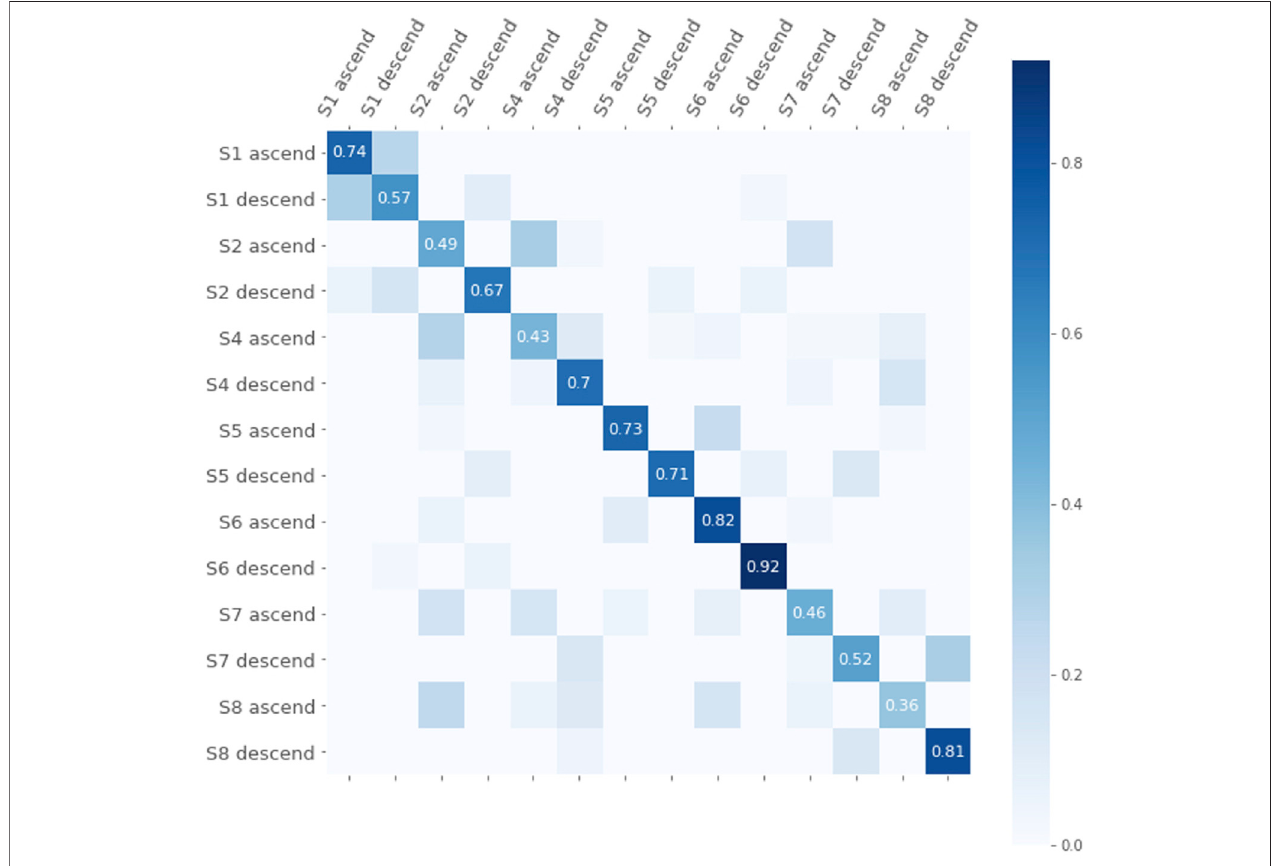
FIGURE 11 | Confusion matrix for the classi fi cation with the kernel based on the 0-th homology standard stable rank and the 1-st homology stable rank with respect to the optimal density.